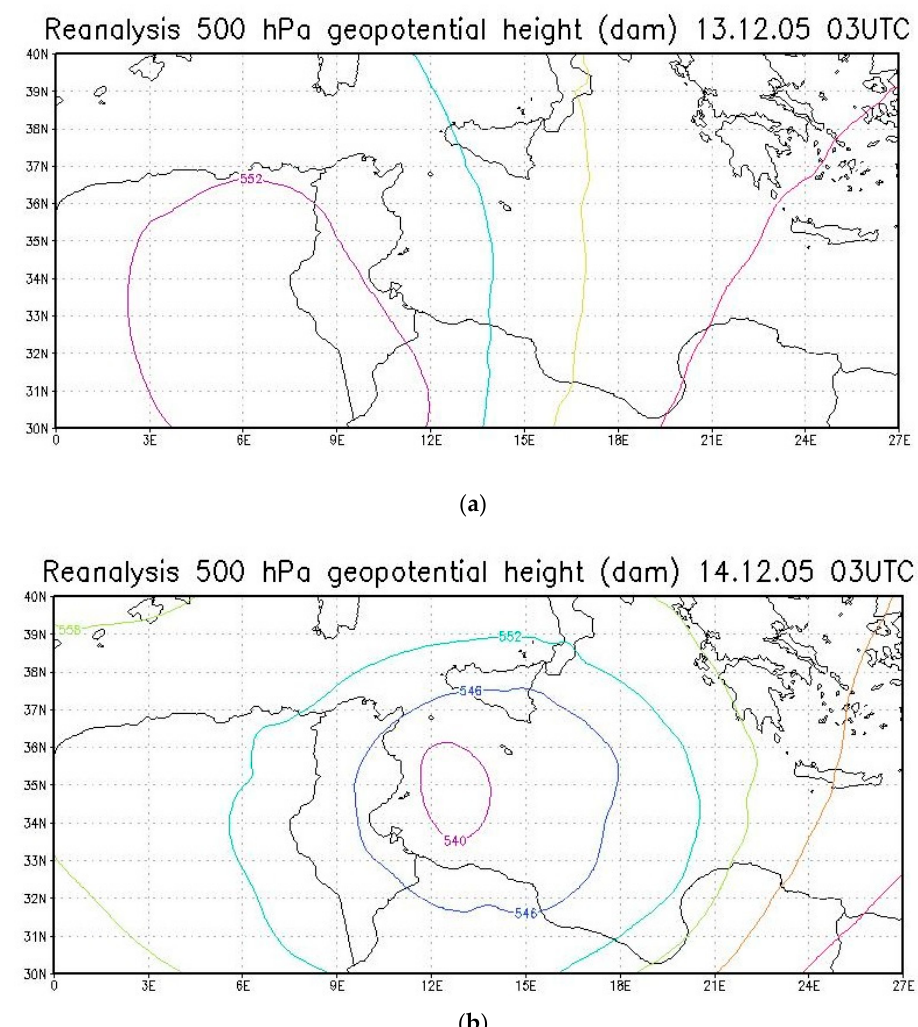
Figure 2. 500 hPa geopotential height (dam) on: ( a ) 13 December 2005 03:00 UTC and ( b ) 14 December 2005 03:00 UTC [20].